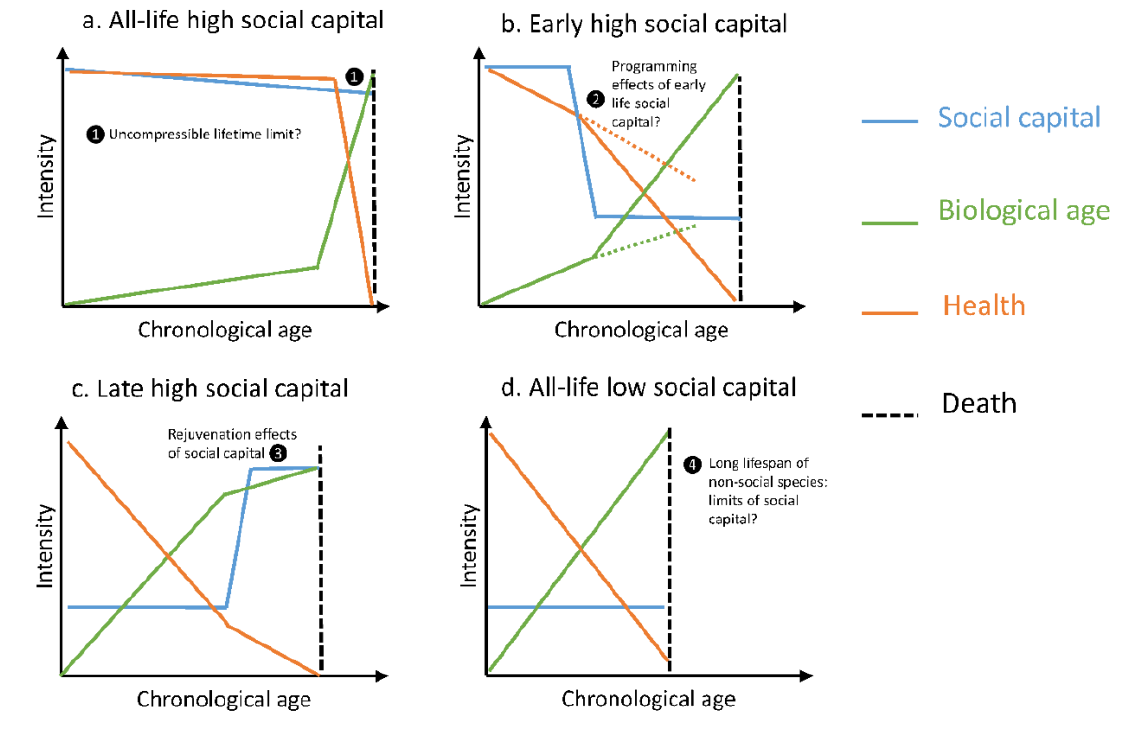
Figure 3: Variation (y-axis) of social capital (blue), biological age (green) and health (orange) over chronological age (x-axis) for an individual having access to (a.) life-long high social capital, (b.) only early- life high social capital, (c.) late-life high social capital, and (d.) life-long low social capital. Curves are theoretical and based on past research conducted in different species that are cited in the main text. They represent the global trajectory of the dimensions over the lifetime of an individual. Health is a state of physical, mental and social well-being that depends on internal (senescence) and external (pathogens, pollutants, etc.) factors. Individuals die when health level reaches zero (dashed black line). Biological age is a sum of intrinsic proxies and predicts health and survival prospects. These schematic representations also raise questions pertaining to the limits of social capital influence (both positive and negative) on longevity and health (❶ and ❹), or indee d on the programming of physiological and social processes in early life that may counteract ageing even if social capital evaporates over age (❷, dashed orange and green lines representing how biological age and health would change without these programming effects). Finally, Figure 3 also highlights the reversible interaction with senescence